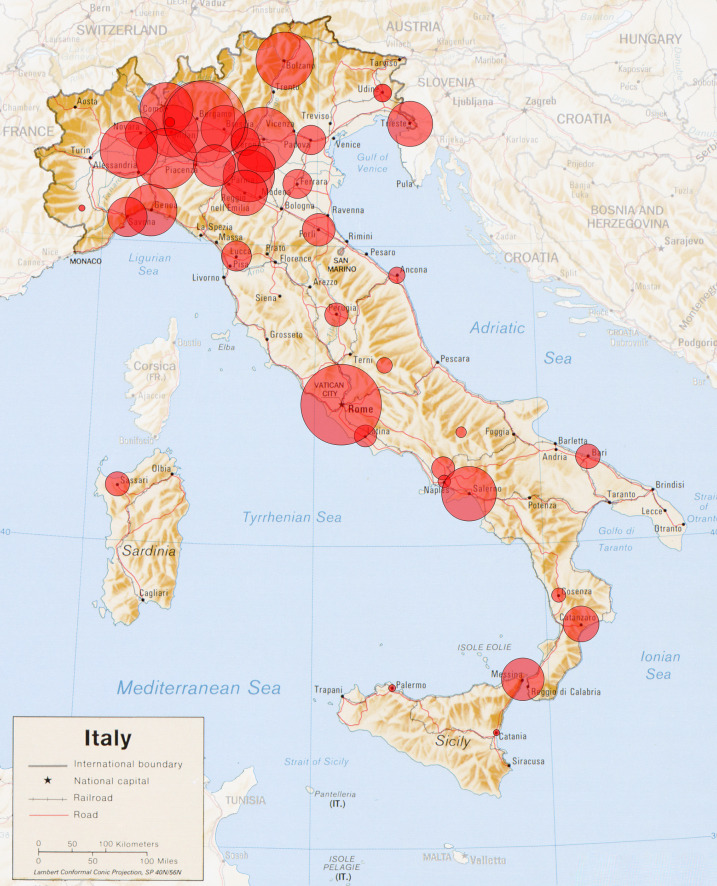
Italian Cartographic representation of the study subjects: Cartographic representation of the patients in this study cohort, with the area of each red circle proportional to the combined number of patients from each compact metropolitan area.